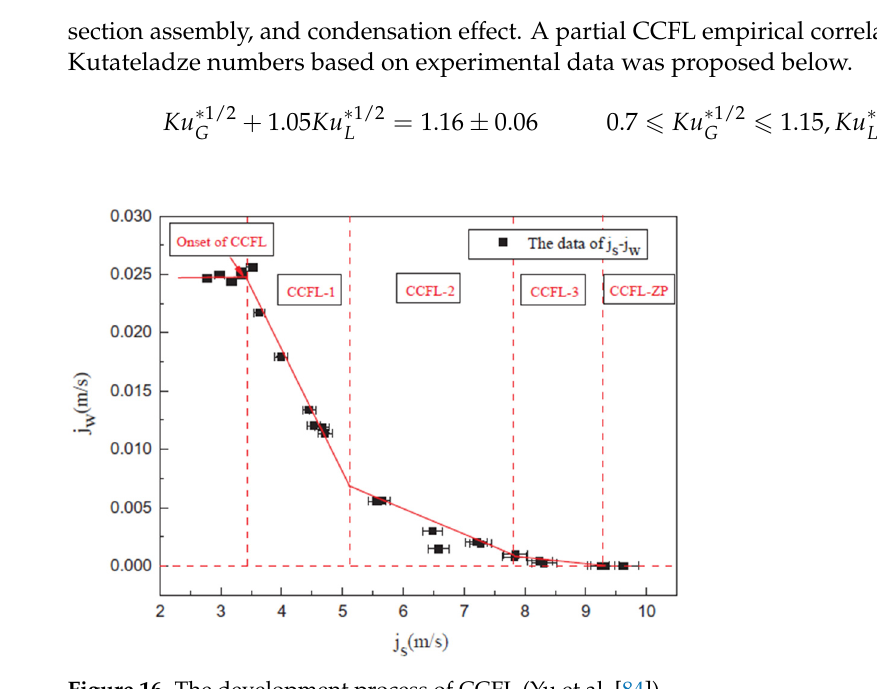
Figure 16. The development process of CCFL (Yu et al. [84]).